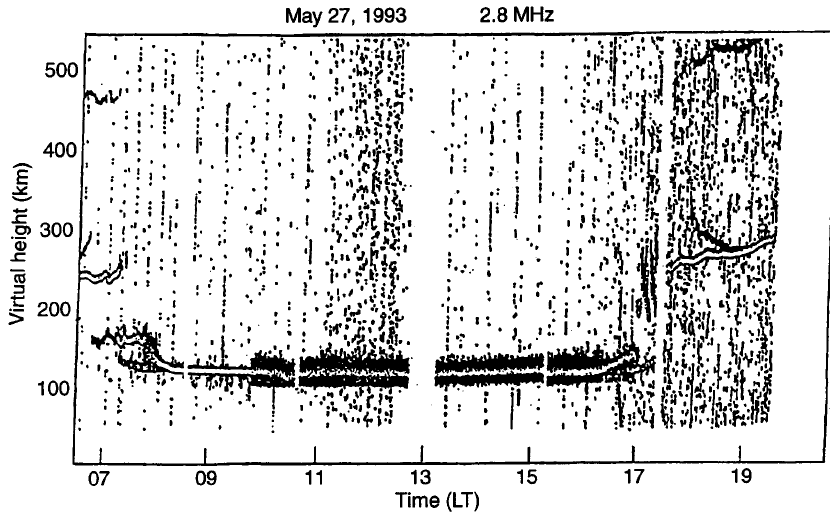
Fig. 9. HF radar plot at 2.8 MHz of the equatorial electrojet irregularities on 27 May 1993 at Korhogo (09.27 (cid:176) N; 05.30 (cid:176) W). Irregularities are absent from 0800–0950 LT. NB: LT (cid:136)